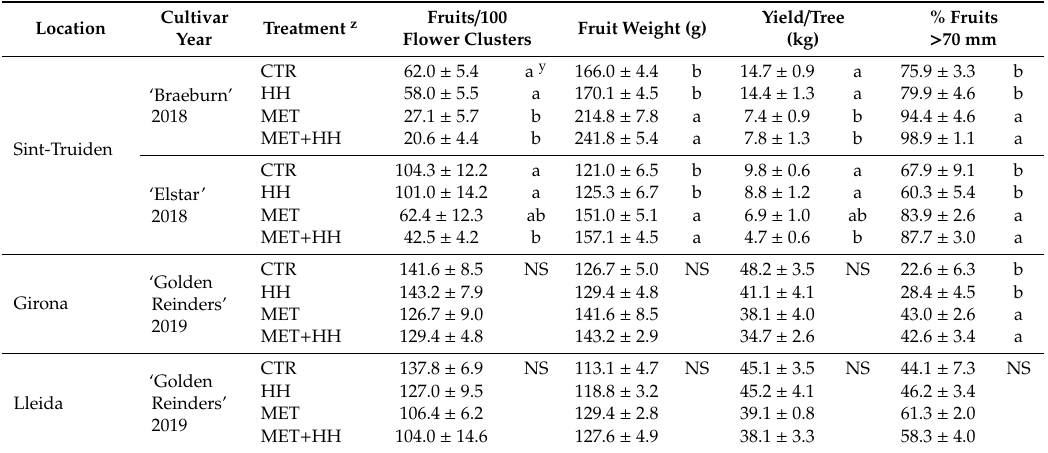
Table 4. The number of fruits per 100 flower clusters, fruit weight (g), yield per tree (kg), and fruits in the fruit size class > 70 mm (%) at harvest, in trials with ‘Braeburn’ and ‘Elstar’ apples performed in Sint-Truiden, Belgium, and with ‘Golden Reinders’ in Lleida and Girona, Spain.